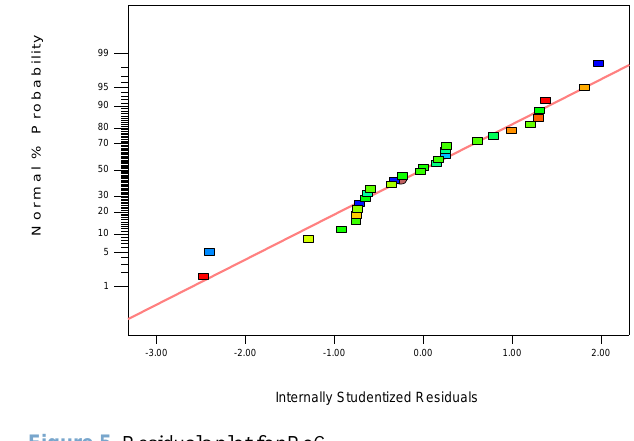
Figure 5 Residuals plot for RoC Figure 5. Residuals plot for